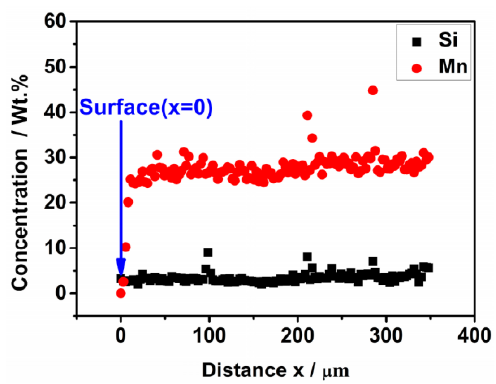
Figure 5. Mn and Si concentration on the cross-section of the MM Fe-Mn-Si alloys sintered at 1200 °C with no isothermal holding.